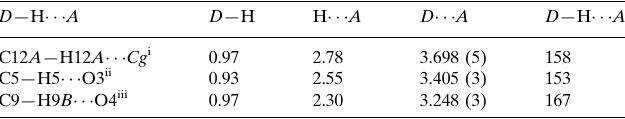
Hydrogen-bond geometry (A˚ , (cid:2)